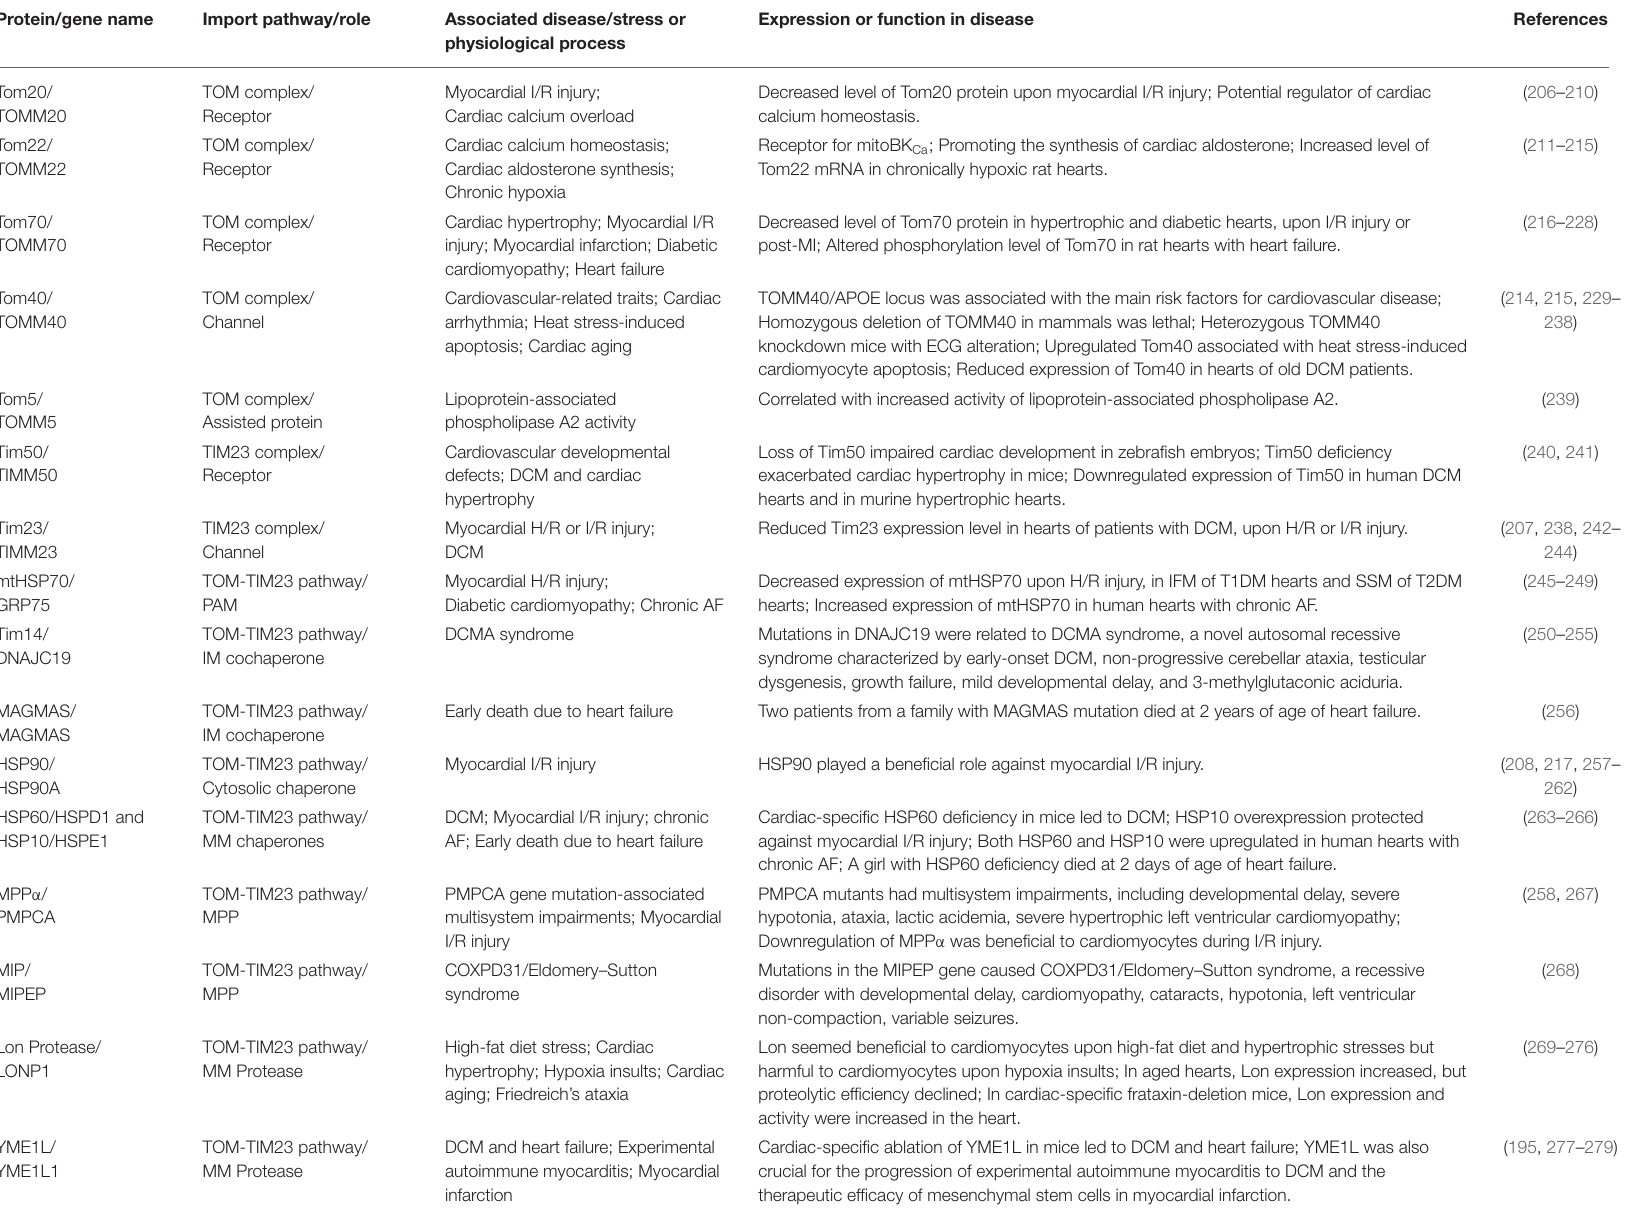
TABLE 2 | Reported proteins or genes in mitochondrial protein import machinery associated with heart